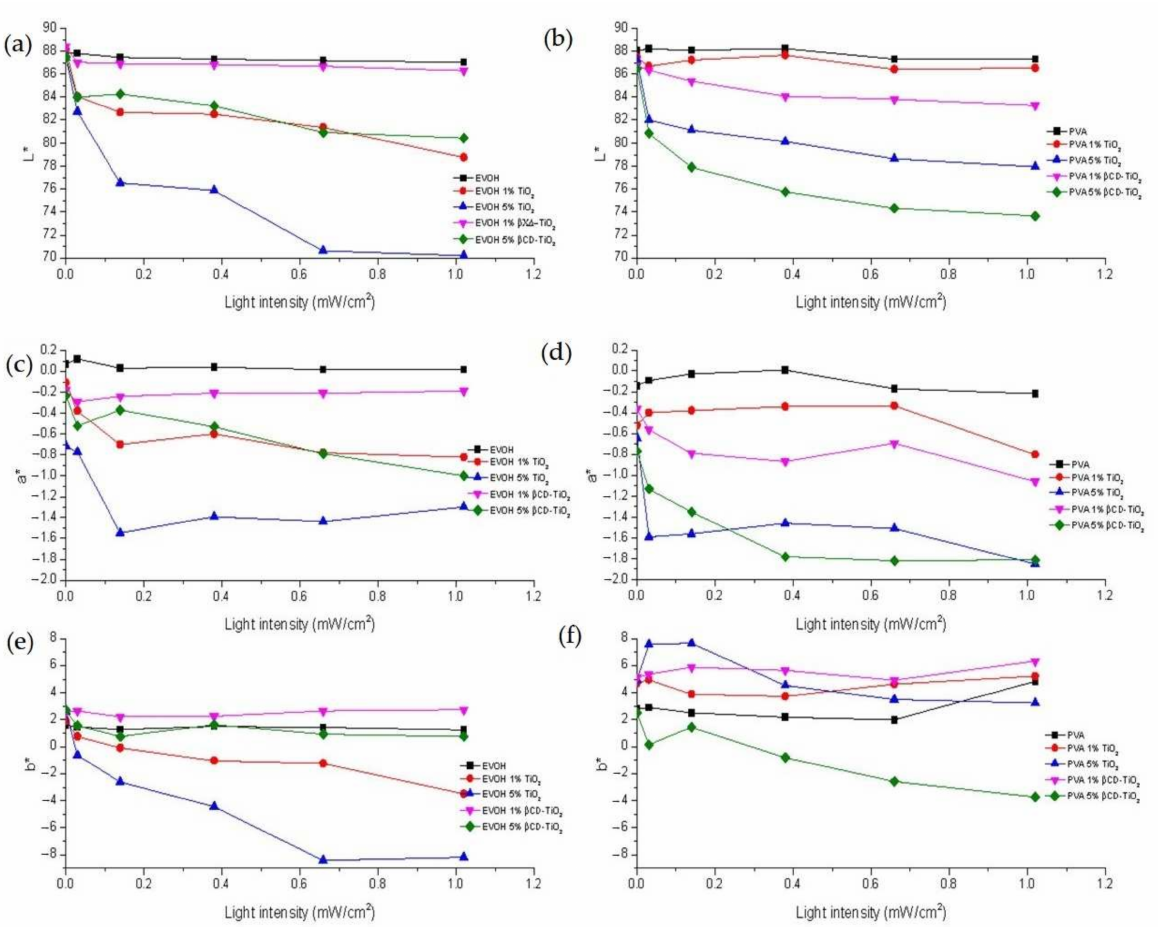
Figure 2. CIELAB values (L*, a*, b*) for EVOH and PVA composite films as a function of UV-A light irradiation intensity. L* coordinates for ( a ) EVOH and ( b ) PVA; a* coordinates for ( c ) EVOH and ( d ) PVA; b* coordinates for ( e ) EVOH and ( f )